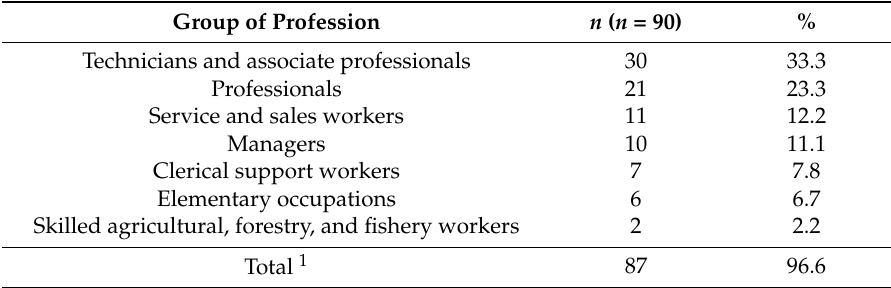
Table 2. Professions of women who worked during their pregnancy ( n =